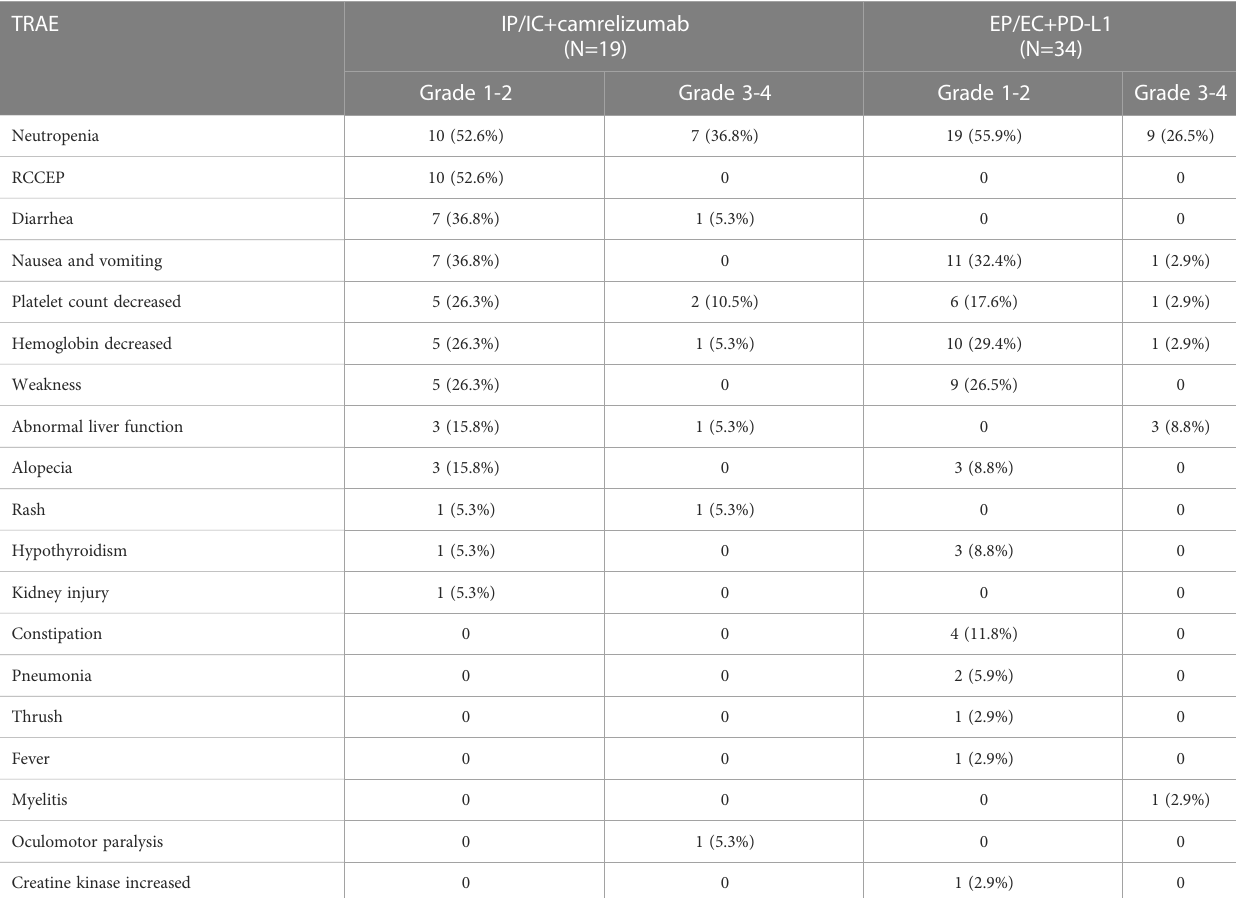
TABLE 3 Treatment-related adverse